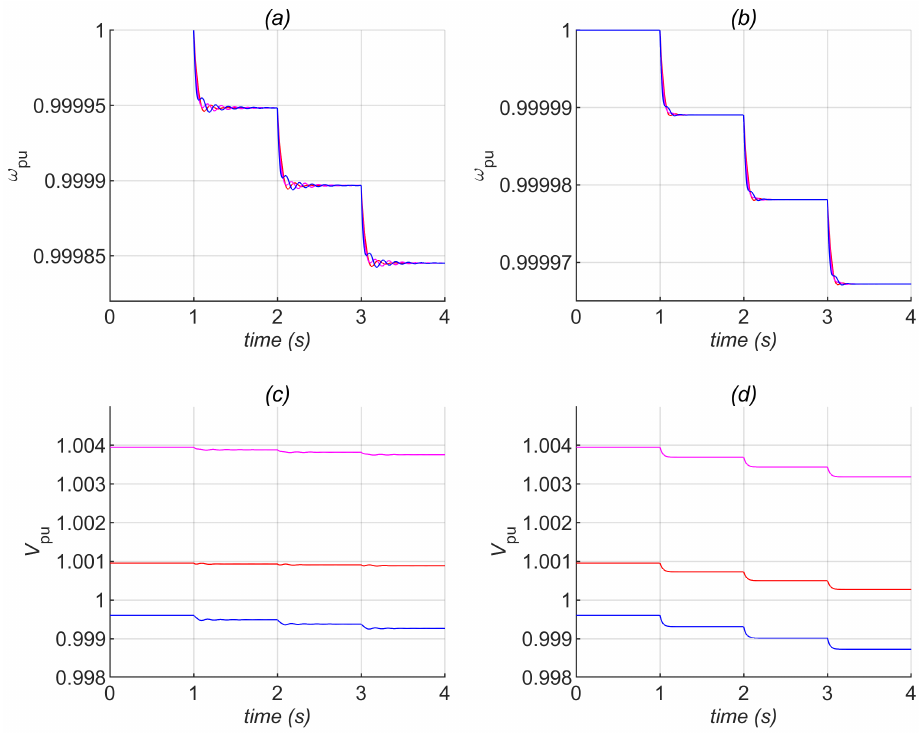
Figure 4. ( a ) Frequency, Conventional, ( b ) Frequency, PFT, ( c ) Bus Voltages, Conventional, ( d ) Bus Voltages, PFT, at VSI Buses (1—red, 2—magenta,